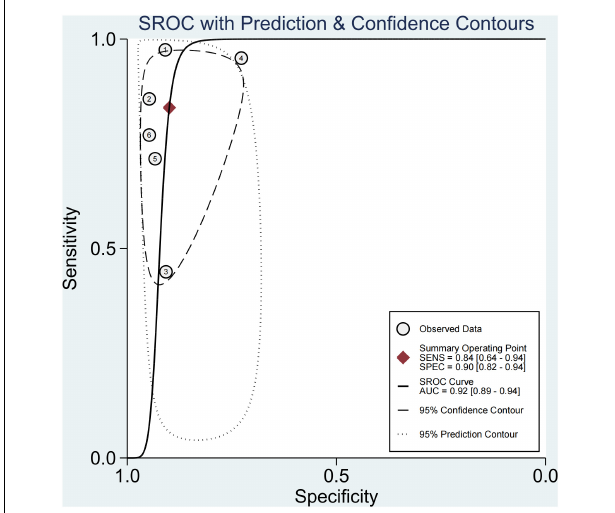
FIGURE 8 | Summary ROC curve of diagnostic performance of elastography for significant fibrosis.